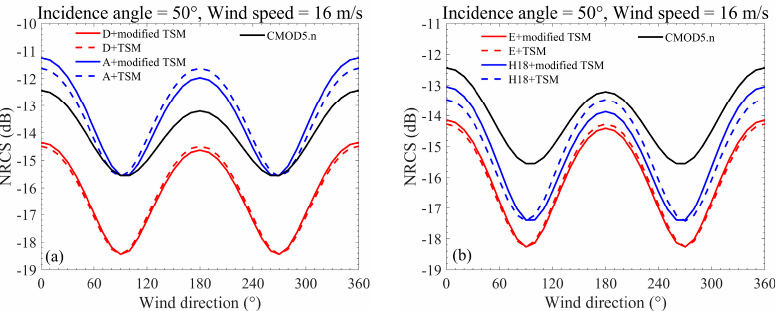
Figure 6. Example of comparison of the NRCSs predicted by the modified TSM (solid curves) and the conventional TSM (dashed curves) using different wave spectra and the Cosine spreading function, and their comparisons with CMOD5.n at wind speed of 16 m/s and incidence angle of 50 ◦ . ( a ) Results obtained with the D and A spectra. ( b ) Results obtained with the E and H18